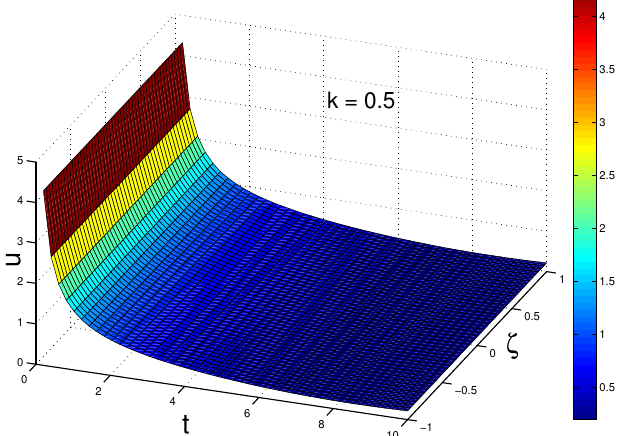
Figure 3. The graph of u ( x , t ) given by Equations (23) and (24) for k = 0.5.